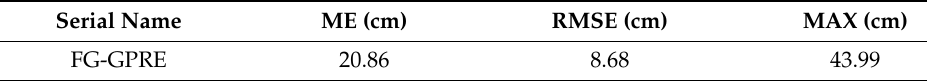
Table 5. Frequency combinations in different modes.